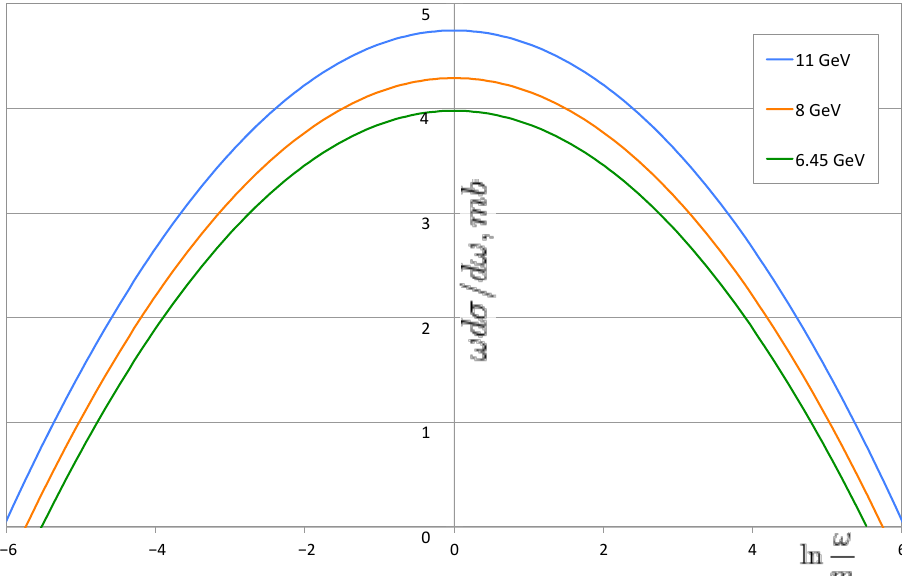
Figure 4. The energy distribution of gamma-quanta from decays of parapositronia produced in ultraperipheral collisions at NICA energies 6.45 GeV ( green ,